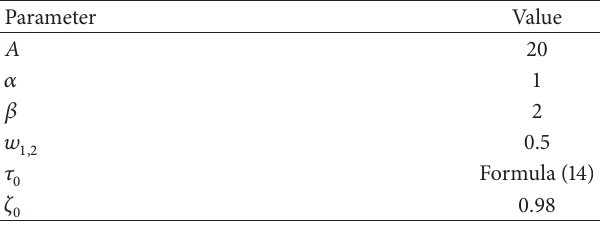
Table 3: Parameters of MPACO algorithm (part).